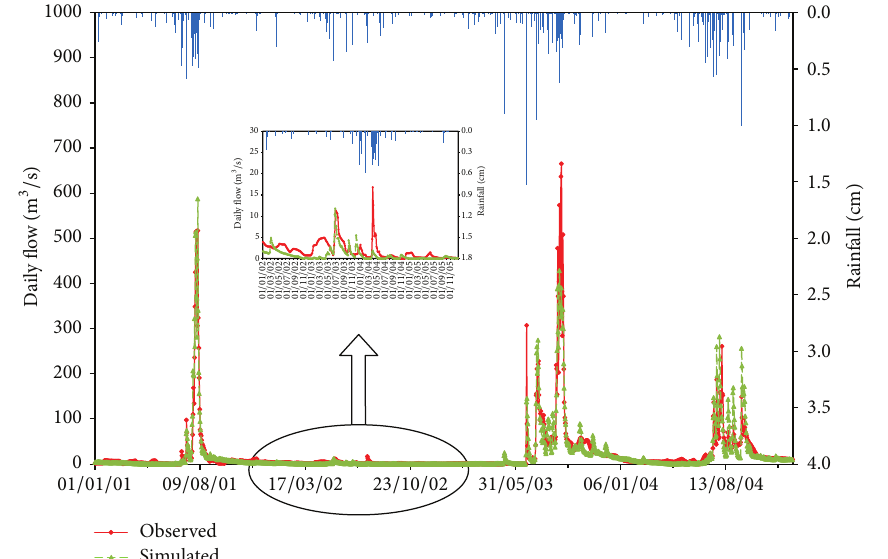
Figure 3: Comparison of observed and simulated results for daily rainfall-runoff simulation in Jiaoyi watershed during calibration period (2001 ∼